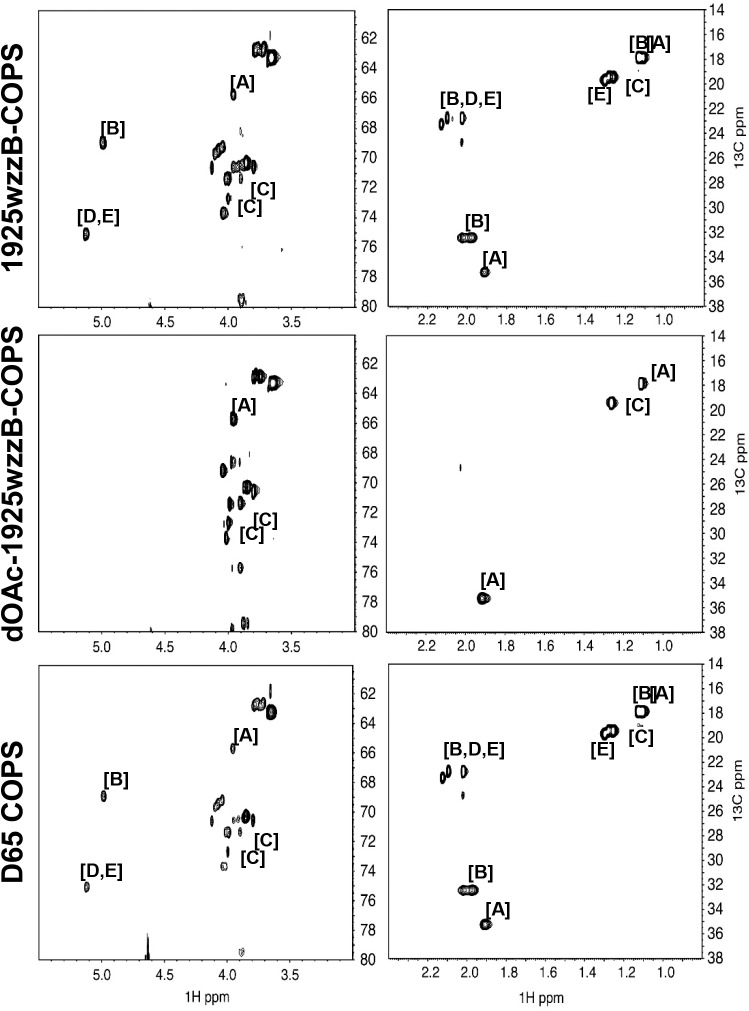
1H and 13C NMR analysis of native and de-O-acetylated 1925wzzB-COPS and native D65 COPS.1H and 13C spectra obtained by 800 MHz NMR are shown for 1925wzzB-COPS, dOAc-1925wzzB-COPS, and D65 COPS. NMR shifts for O-acetylated and native monosaccharides within the COPS polymer are differentiated by letter: α-D-Abequp [A], α-D-Abequp + OAc at C2 [B], α-L-Rhap [C], α-L-Rhap + OAc at C2 [D], α-L-Rhap + OAc at C3 [E].